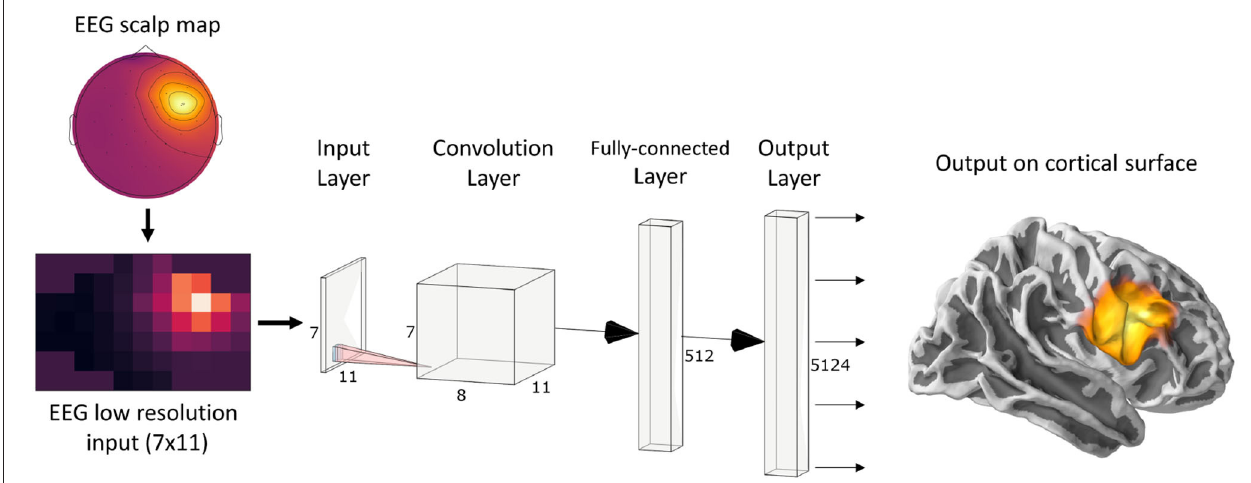
FIGURE 1 | ConvDip architecture. The values from a single time point of EEG data were interpolated to get a 7 left). The subsequent convolution layer has only 8 convolution kernels of size 3 of 512 neurons. Finally, the output layer contains 5124 neurons that correspond to the voxels in the brain (plotted on a cortical surface on the right) (This diagram was created using a web application at